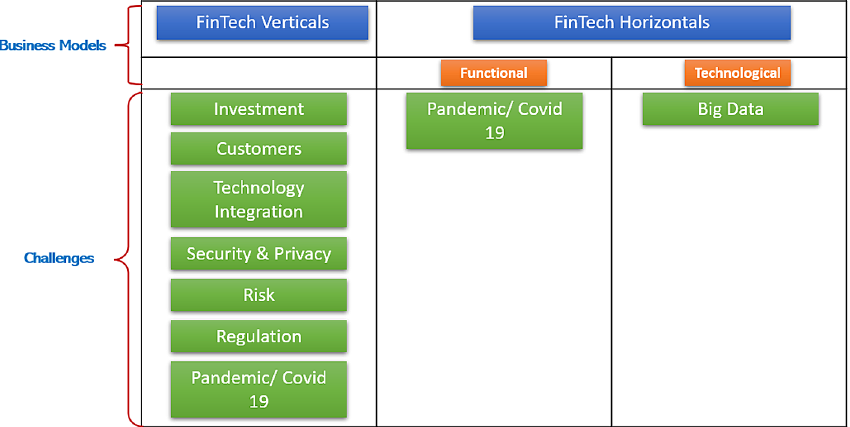
Figure 2. FinTech challenges to business models. Figure was produced by us based on our standing and conclusions of the source articles: (Lee & Shin, 2018; Li & Xu, 2021). FinTech (financial technology); COVID-19 (coronavirus disease